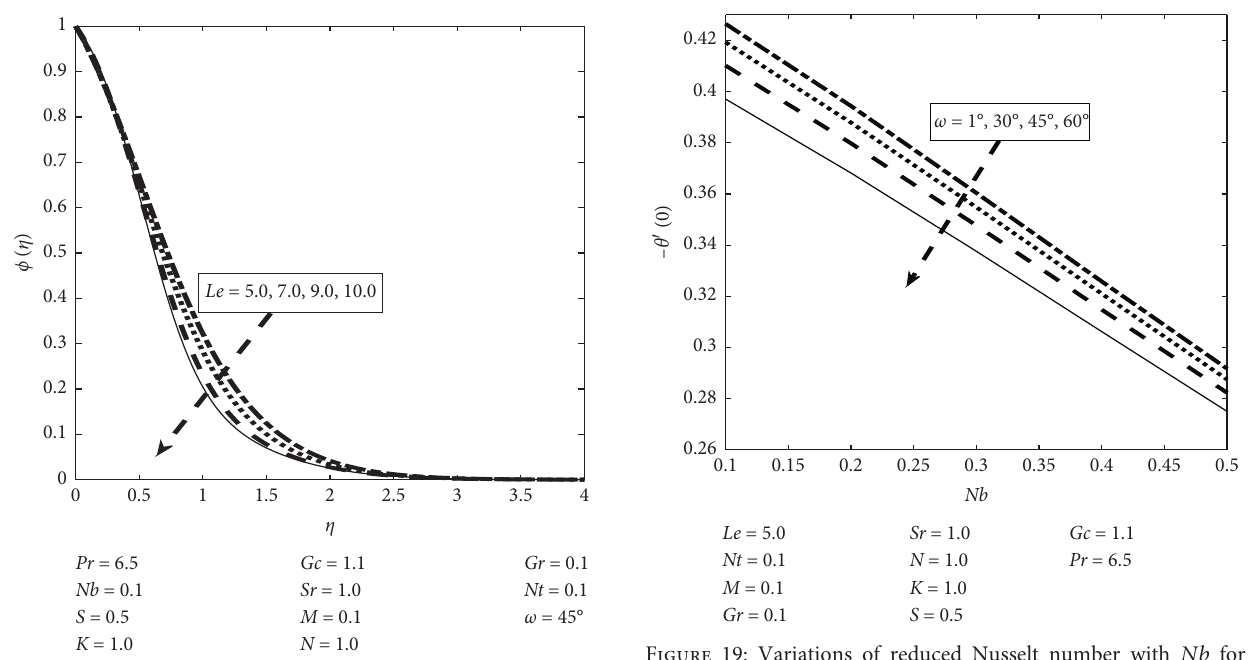
Figure 17: Concentration profile for several values of Le